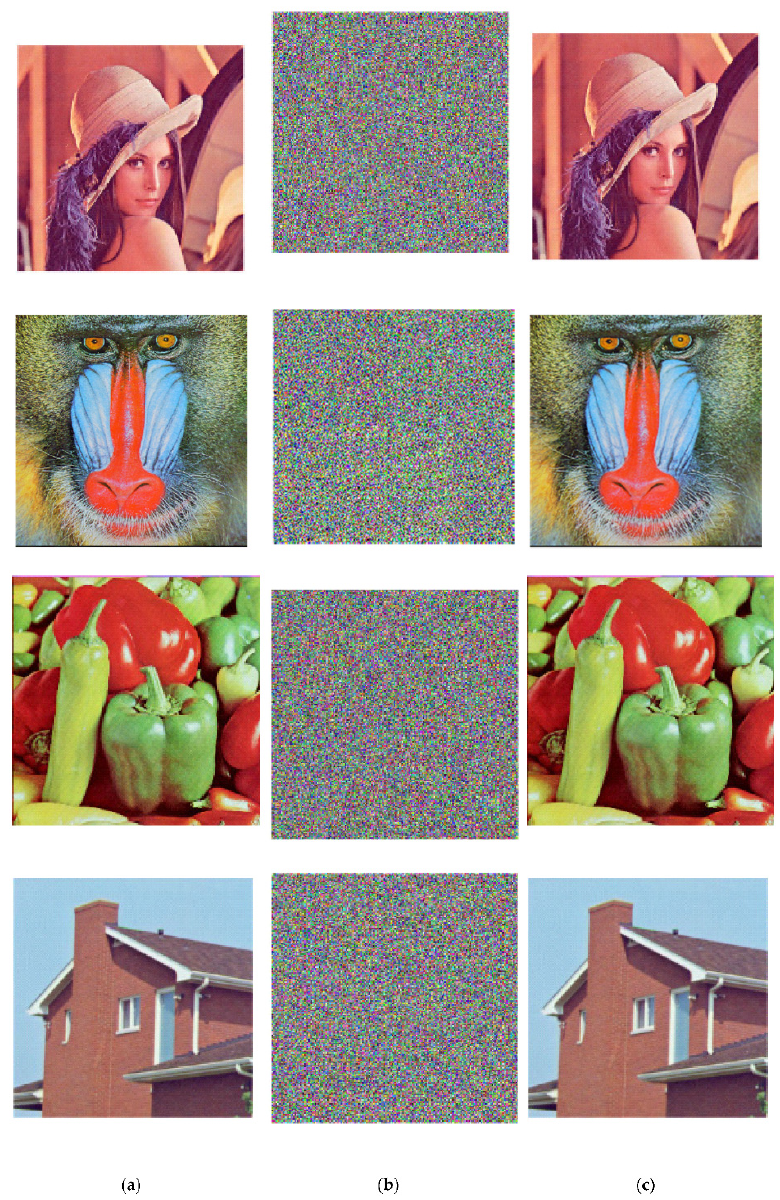
Figure 3. Simulation results. ( a ) Original images, ( b ) Encrypted images and ( c ) Recovered images.